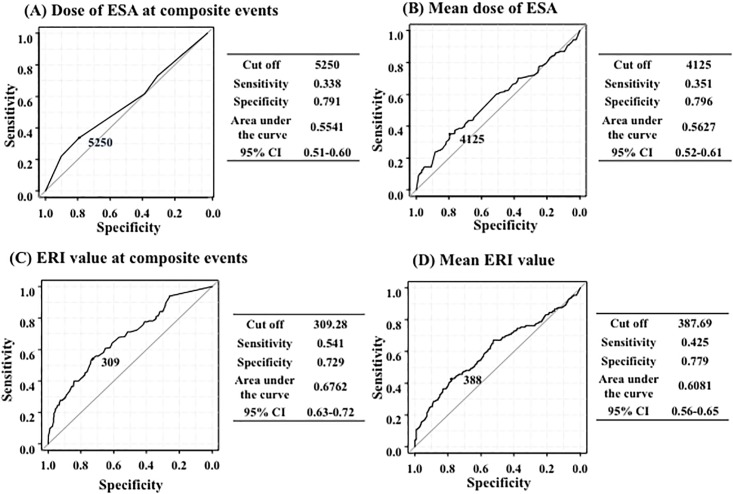
The cut-off values for the ESA dose and ERI for composite events.The cut-off values for the ESA dose (A) and ERI (C) at the time of the composite event were 5250 and 309.28 IU/week, respectively. The cut-off values for the mean ESA dose at the composite event (B) and mean ERI (D) until the composite event were 4,125 and 387.69 IU/week, respectively. According to the Hanley and McNeil method, the area under the curve for the ERI value at the time of the composite event was significantly higher than that of the ESA at the time of the composite event.